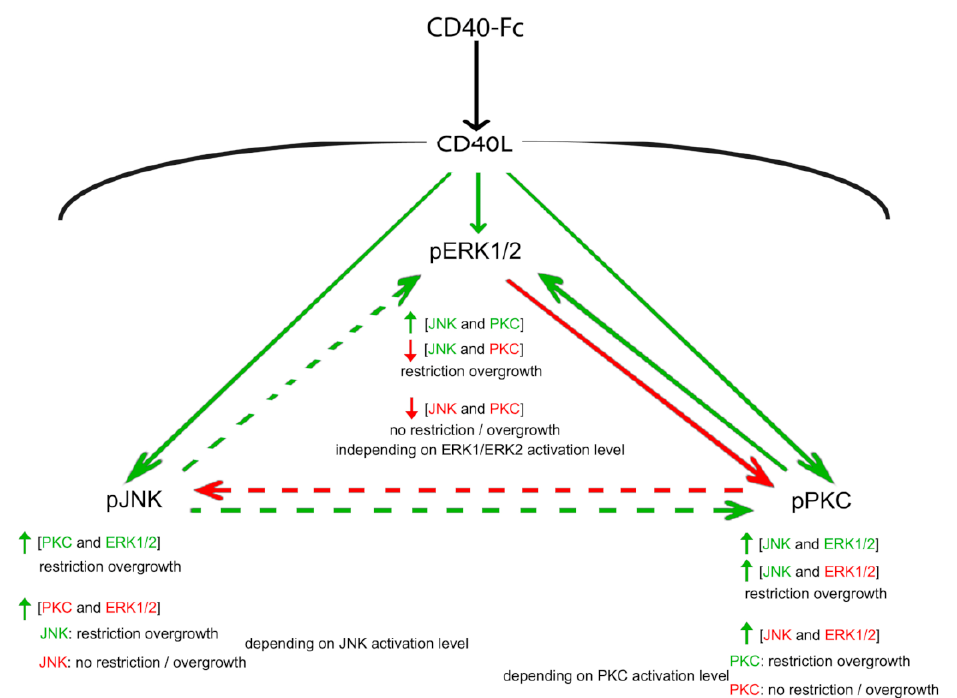
Figure 5. Schematic summary. Graphic summary of the interactions between the JNK, PKC, and ERK1/ERK2 downstream of the activation of CD40L reverse signalling and the effect on neural pro- cess growth. The direction of influence is indicated by the arrows. Solid arrows indicate the influence of activation that is opposite to the influence of inhibition (i.e., activator of ERK1/ERK2 reduces phospho-PKC and the inhibitor of ERK1/ERK2 increases phospho-PKC; or activator of PKC increases phospho-ERK1/phospho-ERK2 and the inhibitor of PKC reduces phospho-ERK1/phospho-ERK2); dashed arrows indicate the influence of activation that do not have any influence when inhibiting (i.e., activator of PKC reduces phospho-JNK, but the inhibitor does not have any effect). The change in the level of phosphorylation is indicated by colour (green denotes increased phosphorylation and red denotes decreased